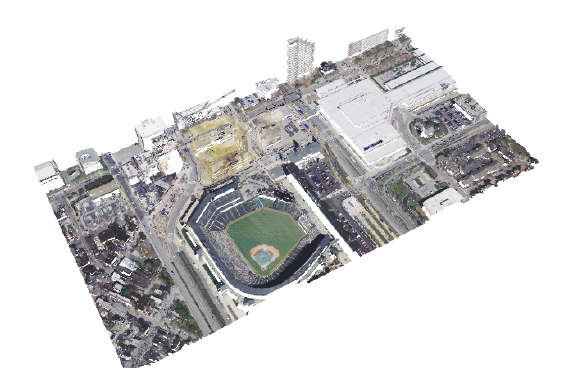
Figure 3. Original Laz. Data and Visualization in ArcScene